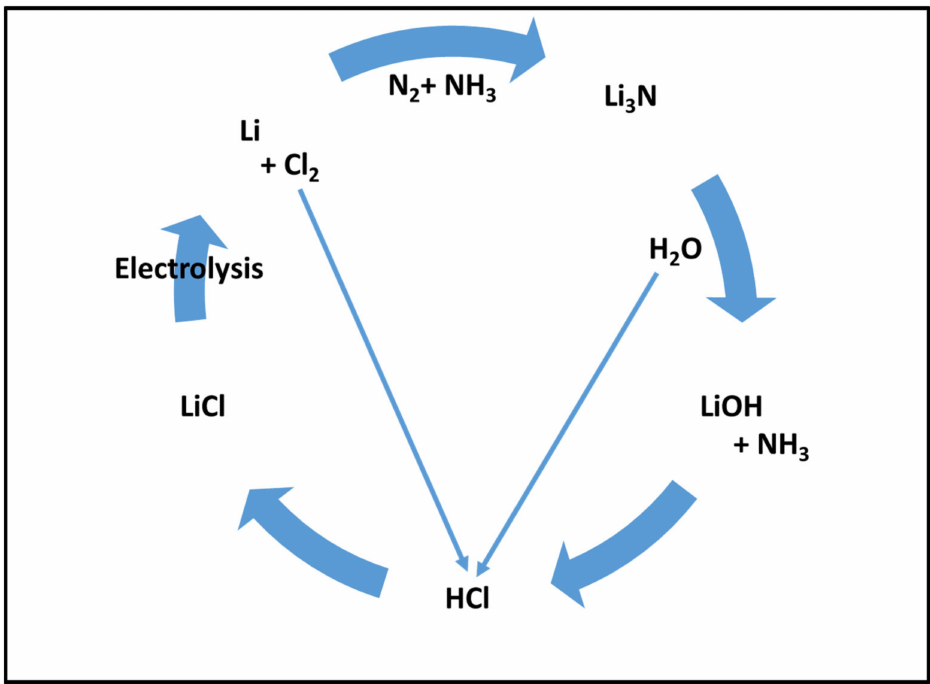
Figure 6. Lithium-based cycle for upfront N 2